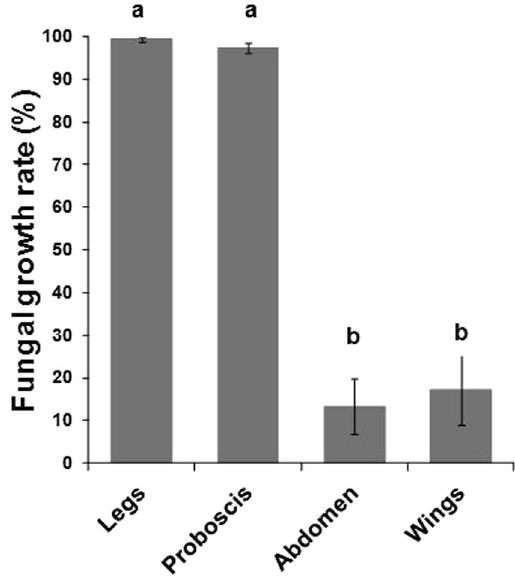
Figure 1. Mean percentage of fungal growth on each body part of the mosquito. Error bars represent the standard error of the mean (n = 90). Different letters indicate significant differences among the body parts ( p < 0.01, Tukey’s honest significant difference